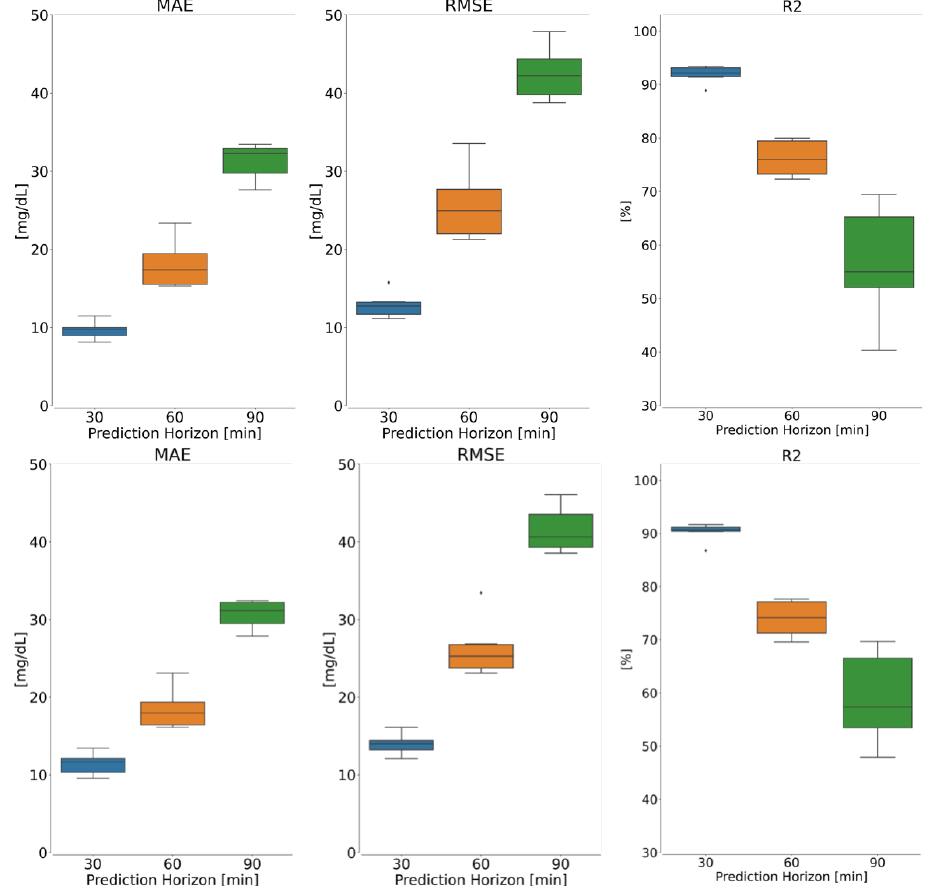
Figure 4. Box plot showing the patient-wise results for (top) LSTM and (bottom) CNN-LSTM models in terms of ( left ) MAE, ( middle ) RMSE and ( right ) R2 metrics, given scenario 7 as dataset. In each panel, blue, orange and green are boxplots for 30, 60 and 90